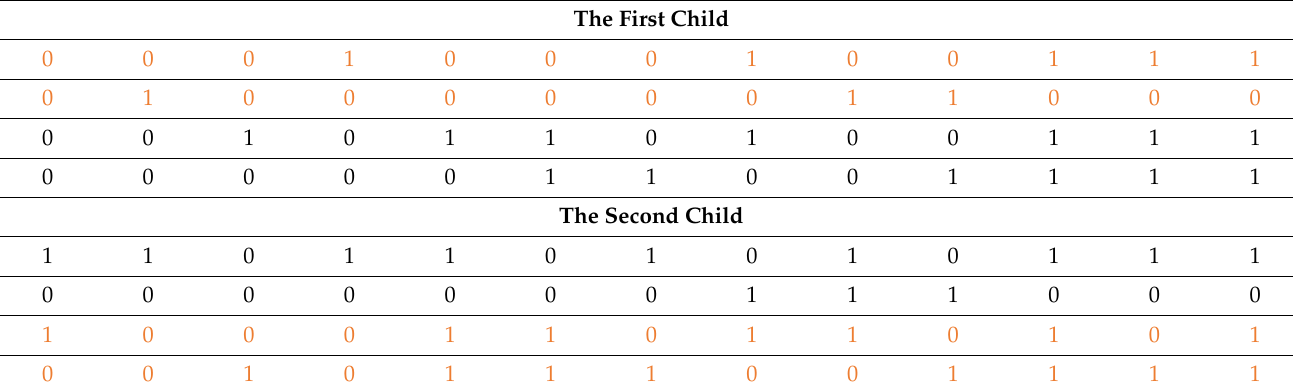
Table 8. Children of linear (horizontal) cross operator.